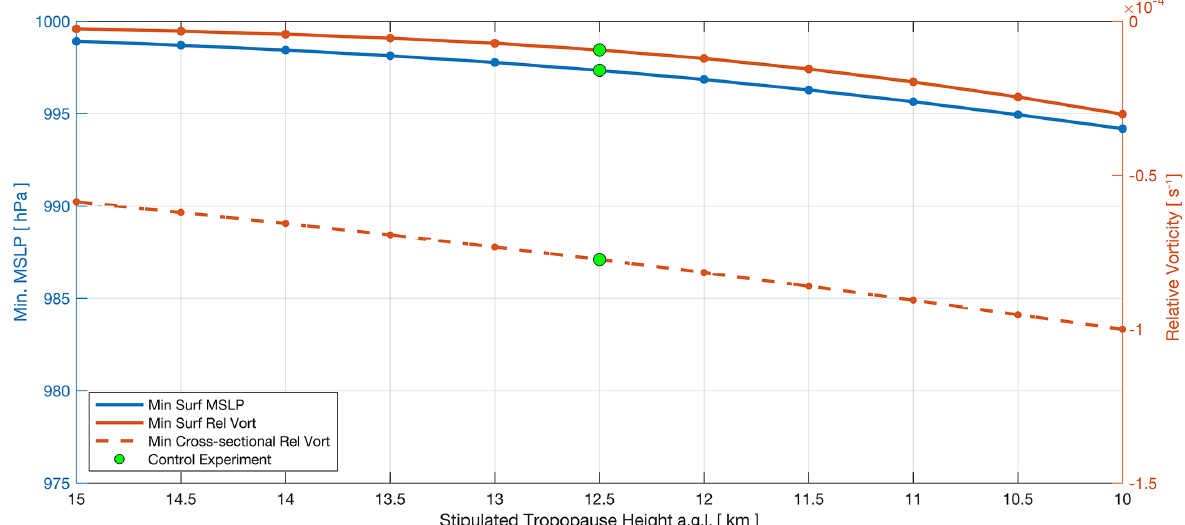
Figure 10. Similar to Fig. 8 but for Experiment 2 (varying tropopause height experiments) with tropopause height a.g.l. shown on the x